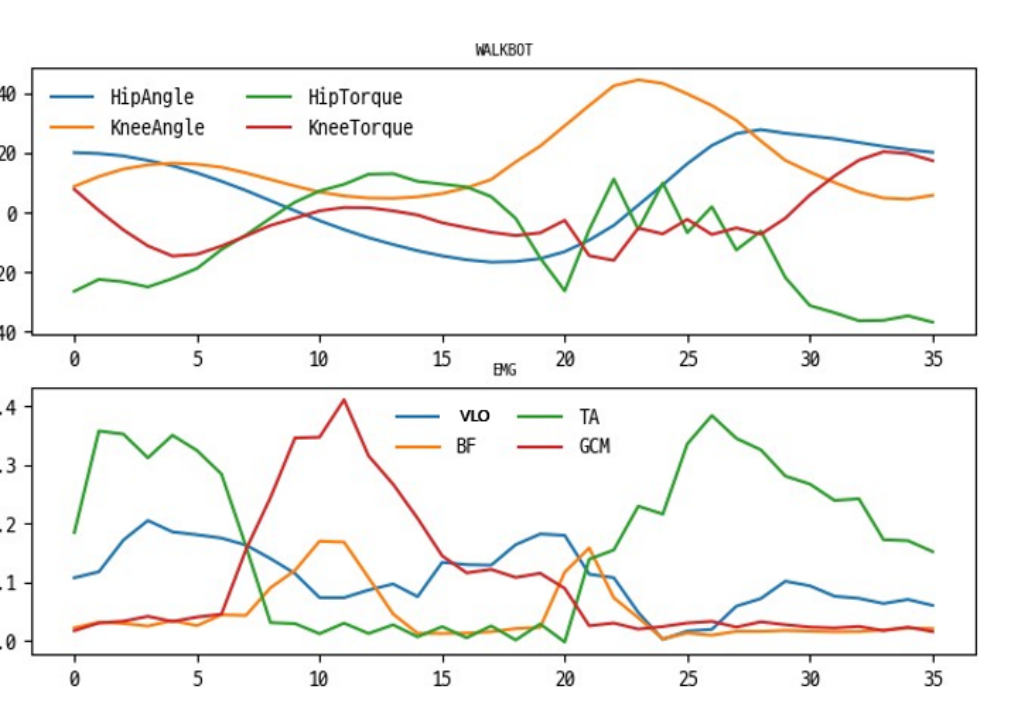
Figure 4. Example of EMG and torque signals corresponding to one gait cycle .